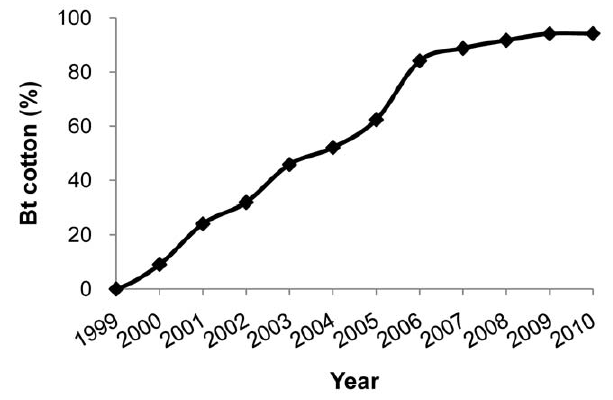
Figure 2. Percentage of cotton hectares planted with Bt cotton in the Yangtze River Valley, 1999 to 2010.